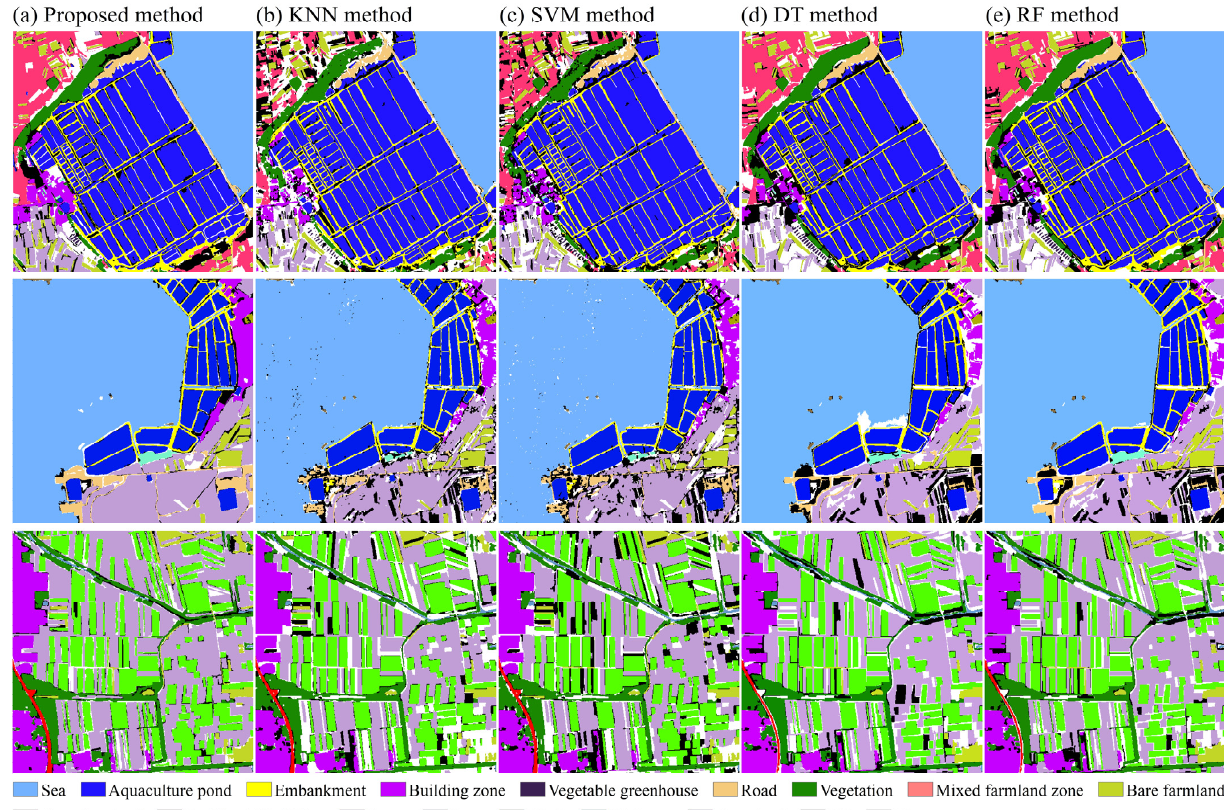
Figure 13. Comparison of the proposed method with the KNN, SVM, DT, and RF methods. Different background colors in the imagery represent different land cover types. The FN and FP represent two types of misclassification results: false negative and false positive.